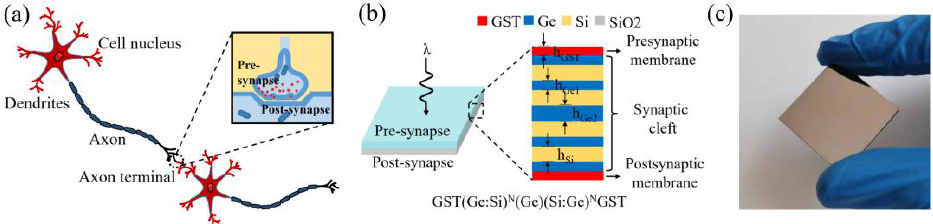
Figure 1. ( a ) The schematic diagram of biological synapses. ( b ) The schematic diagram of on-chip photonic synaptic structures. ( c ) The physical picture of on-chip photonic synaptic.